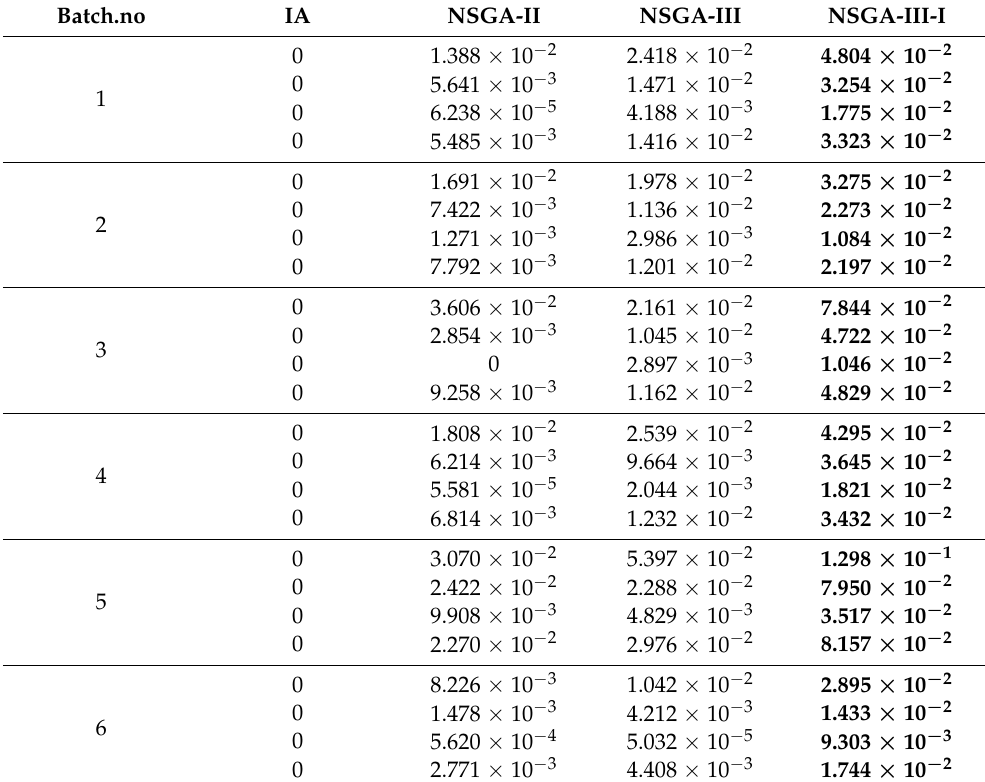
Table 5. Performance comparison between the proposed algorithm and other algorithms on the experimental problem with a batch size of